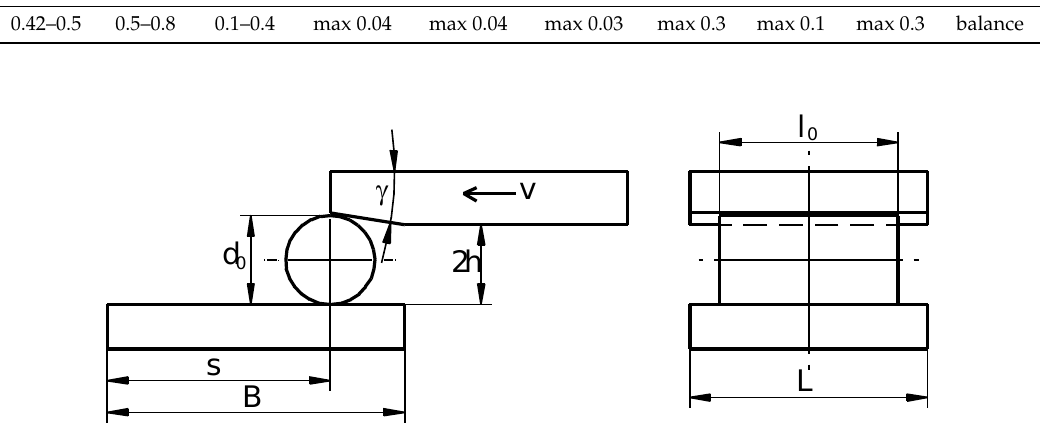
Figure 1. Scheme of the rotational compression test of bars, performed using two flat tools.